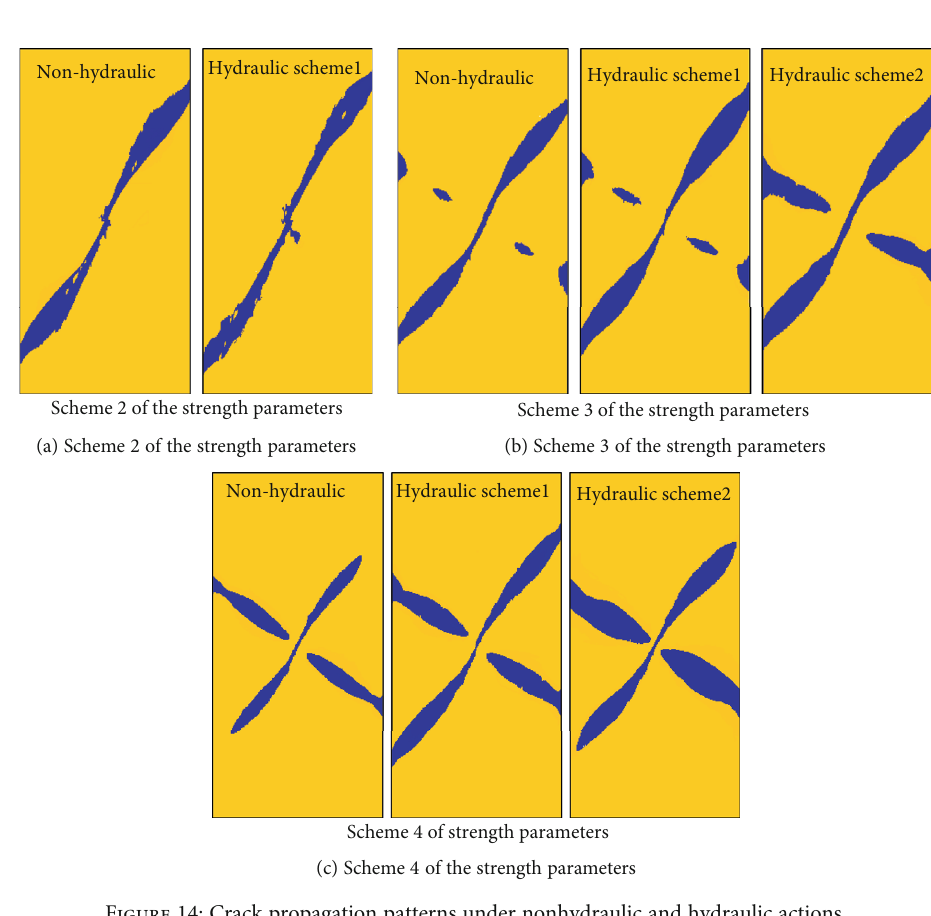
Figure 13: Evolutions of the maximum shear stress under continued mechanical loading: (a) scheme 3 of the strength parameters; (b) scheme 4 of the strength parameters.